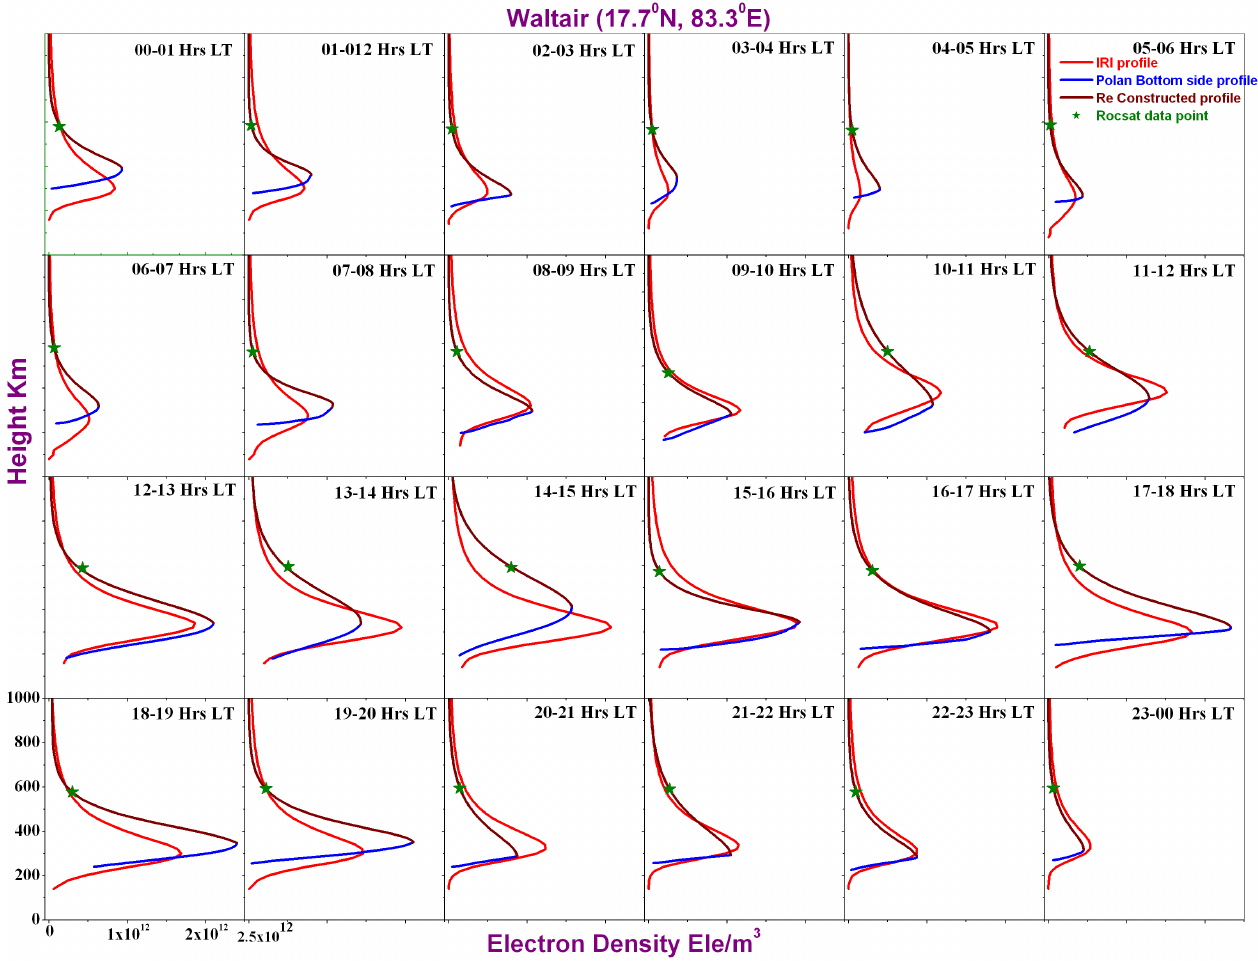
Fig. 5. Vertical electron density profiles reconstructed using ionosonde and ROCSAT data along with the simultaneous IRI model derived profiles for all the hours of the day over a low latitude station